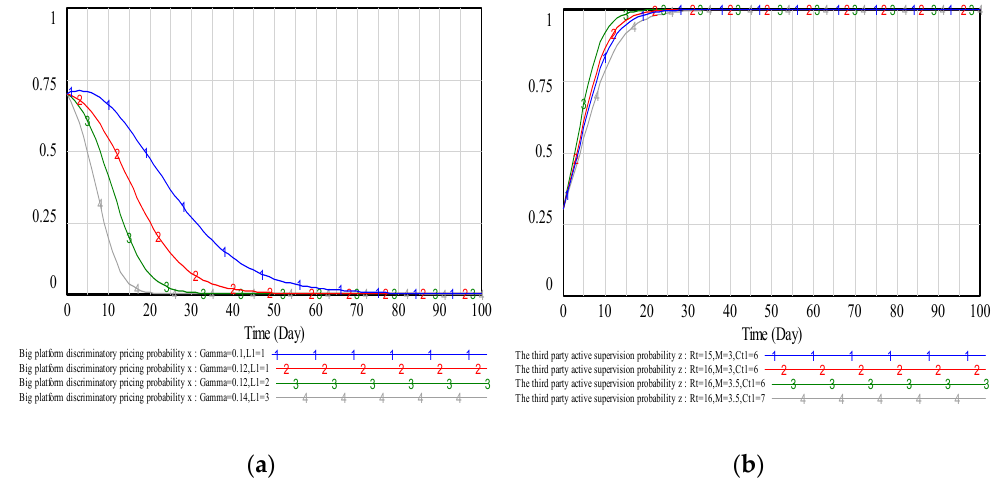
L on the strategy 1 R , M , and C on the strategy choice of the third t 1 t